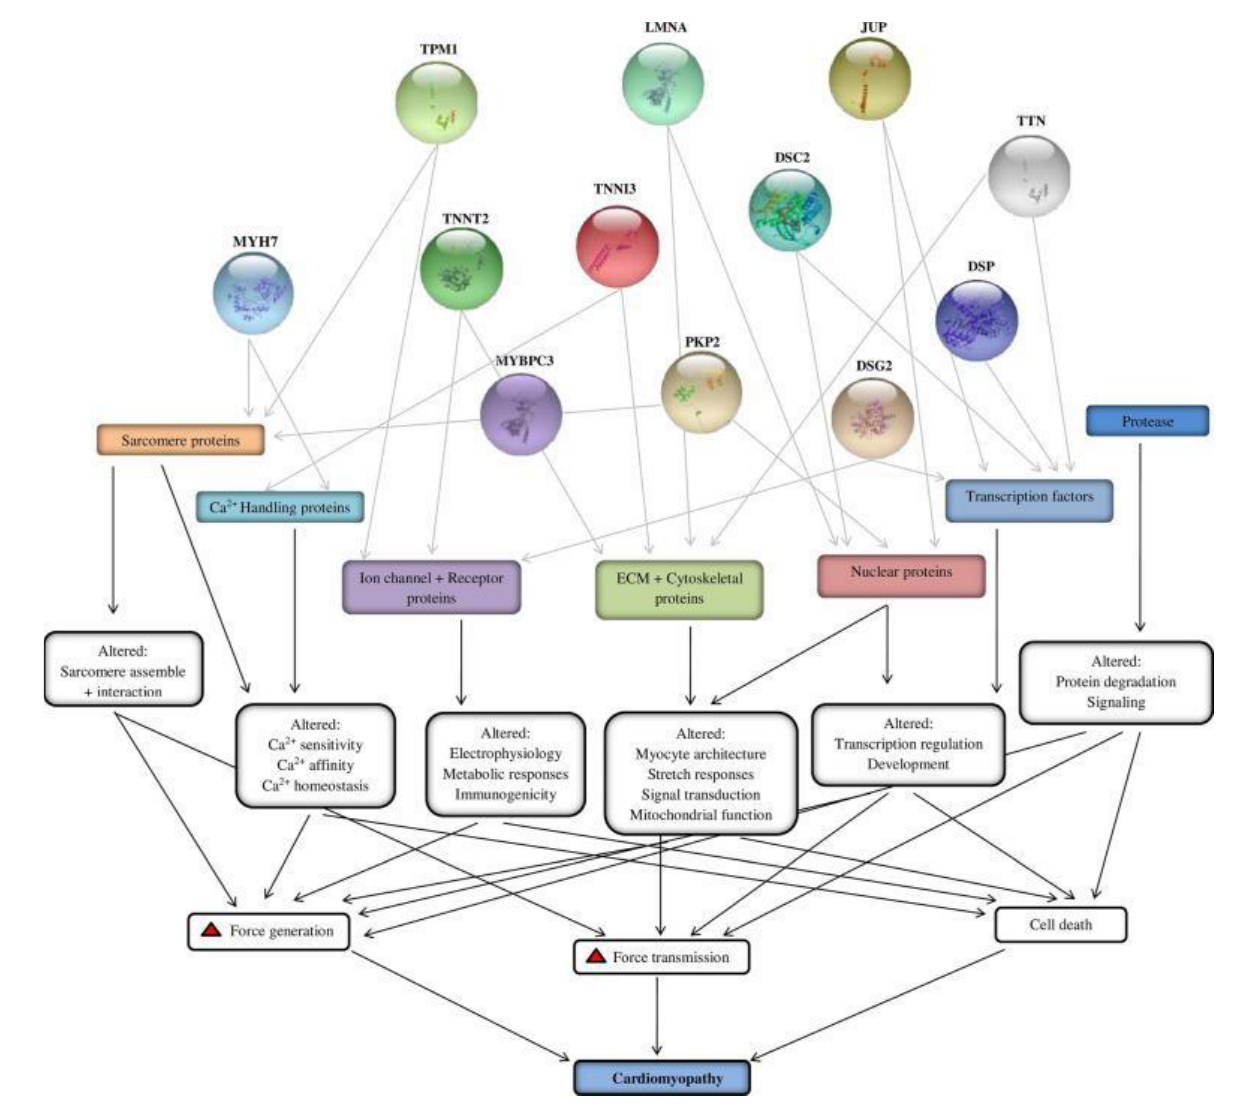
Figure 2. Important genes involved in cardiomyopathy and their effect on the structure and function of cardiomyocytes, adopted with permission from Kaviarasan et al. [77]. Table 2. Significant genes associated with different categories of cardiomyopathy with mode of inheritance [76,77].